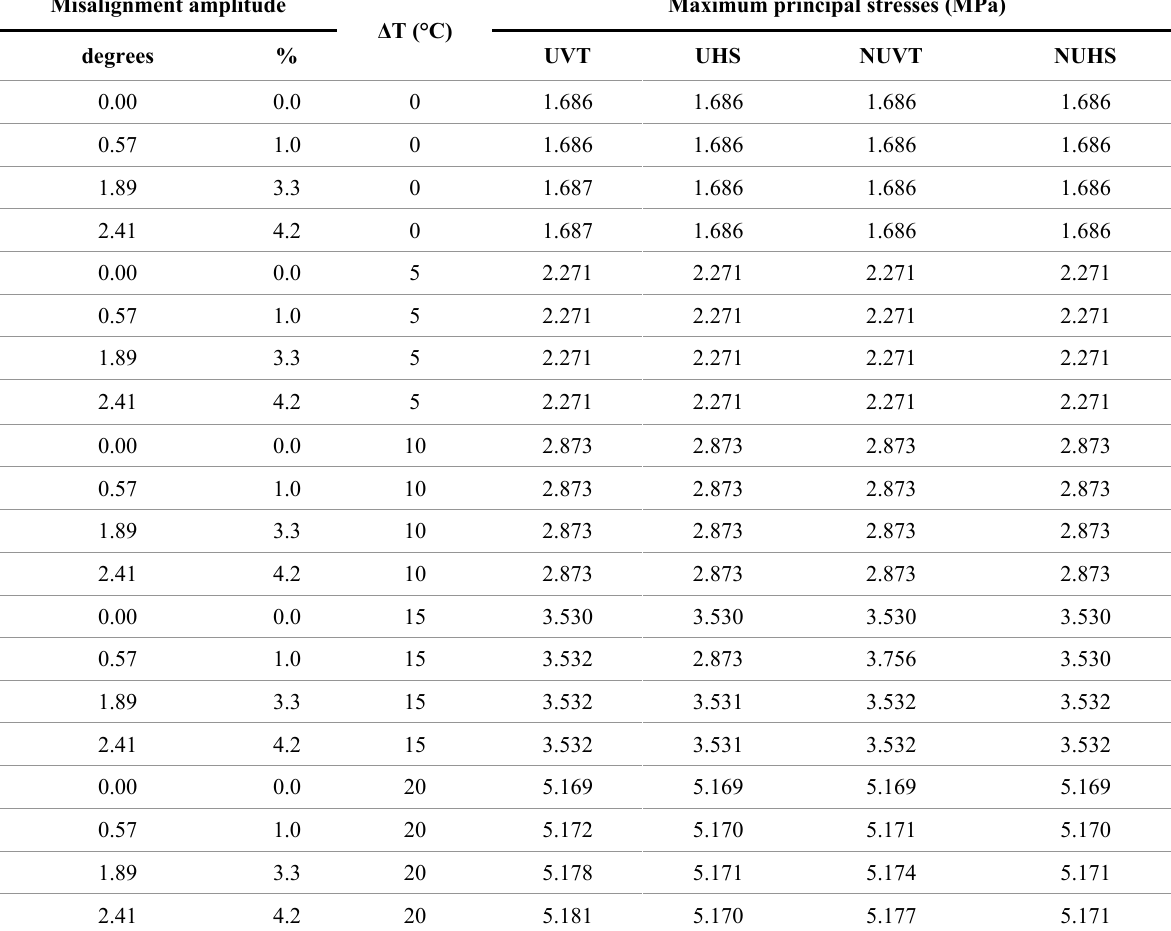
Table 5. Maximum principal stresses caused by misalignment and thermal